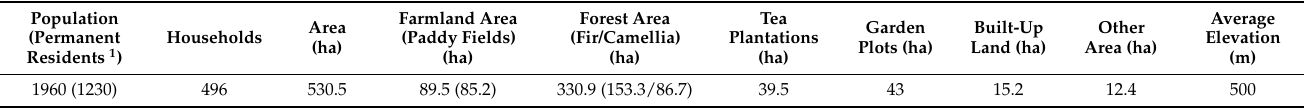
Table 1. Official information about Gaoyou